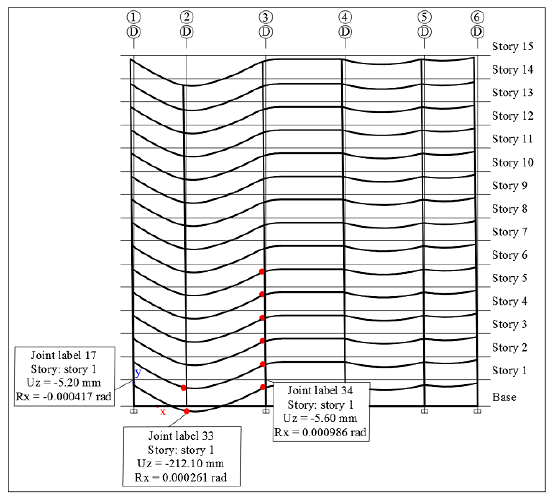
Figure 11. Displacement response at the location of removed column D2 when moment frames are located at perimeters and along grid lines B, C, D, E, F and G (non-linear dynamic case 19).